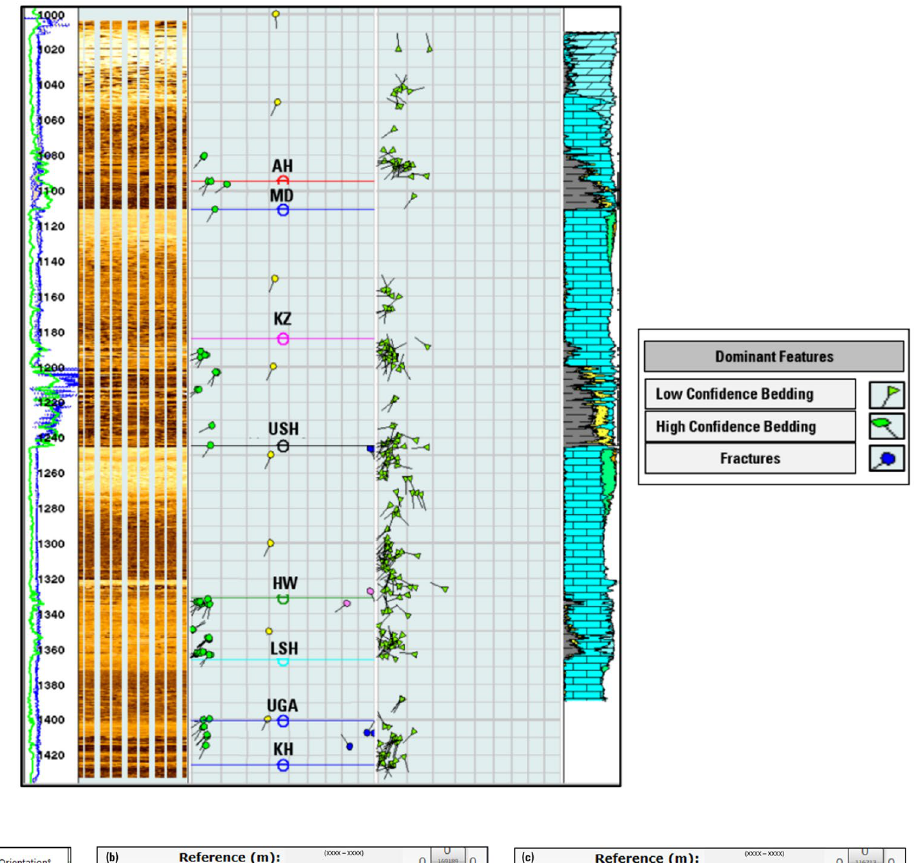
Fig. 13 Image log interpretation (bedding in green and fracture in blue one) in well #2